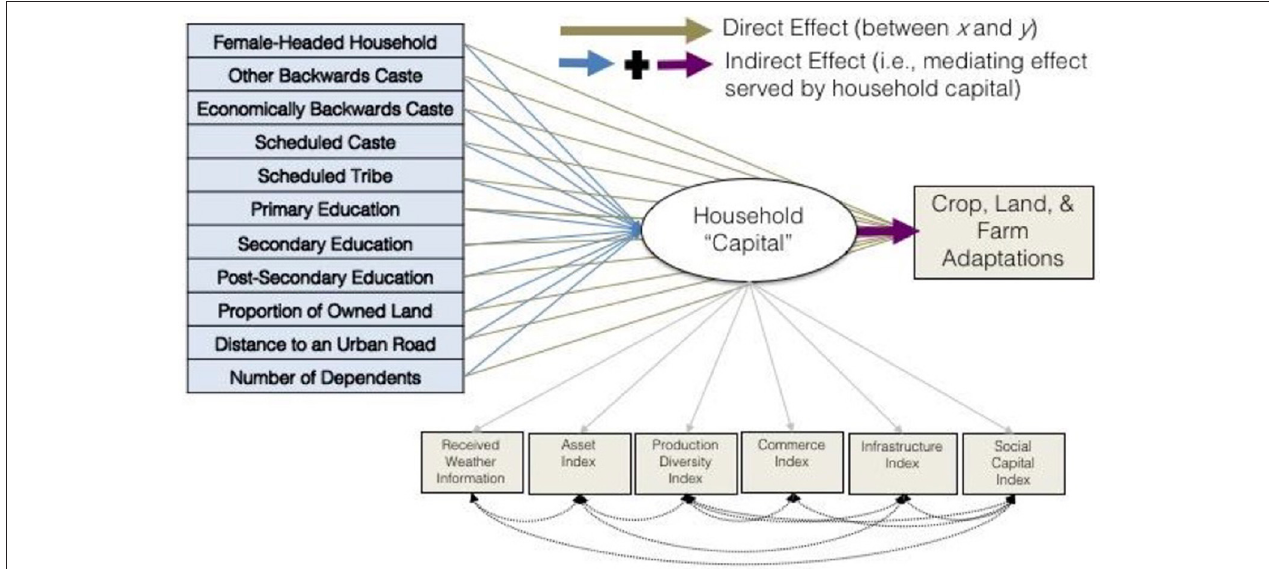
FIGURE 3 | Mediated models ran for crop, land, farm adaptation behavior in Haryana and Bihar.